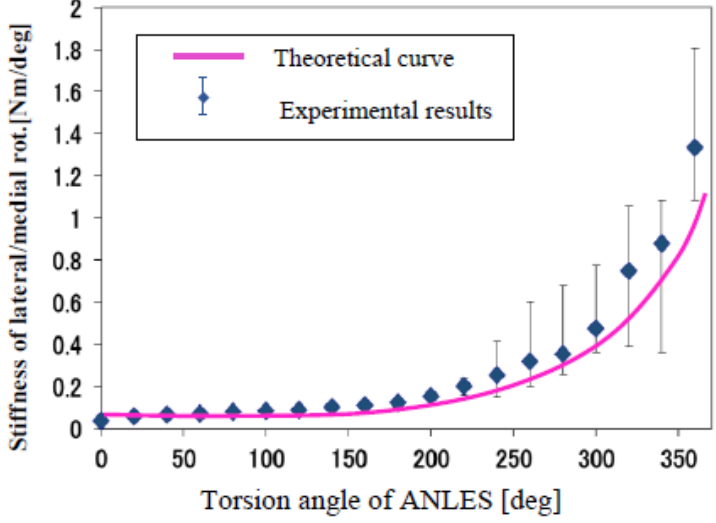
Figure 12. Stiffness about the lateral/medial rotation of the